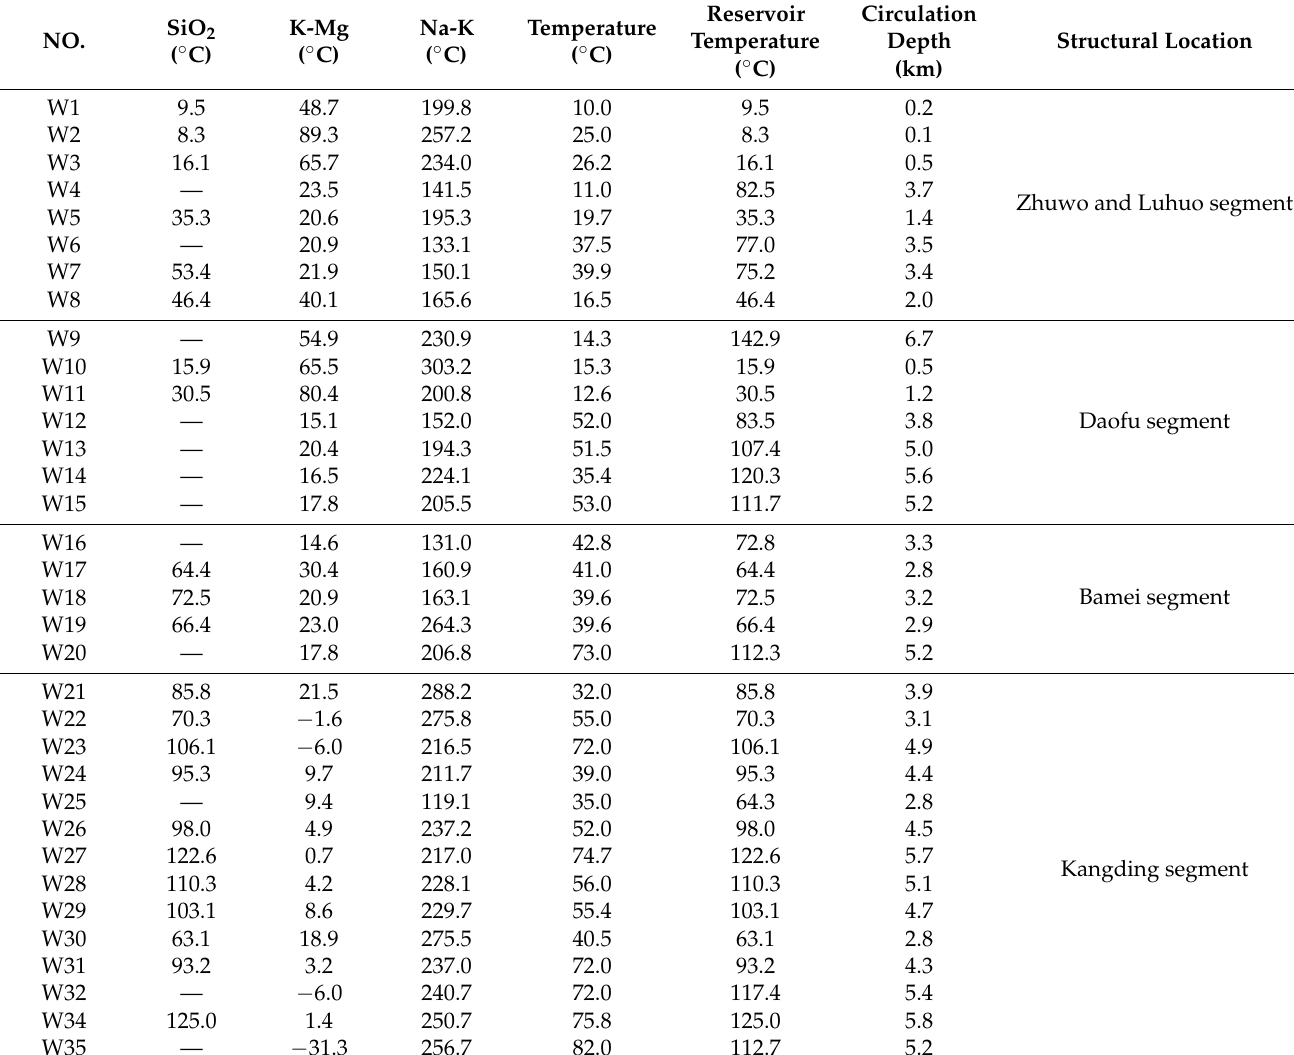
Table 3. Apparent equilibrium temperatures were computed through multi-geothermometers for the samples collected from the thermal springs of